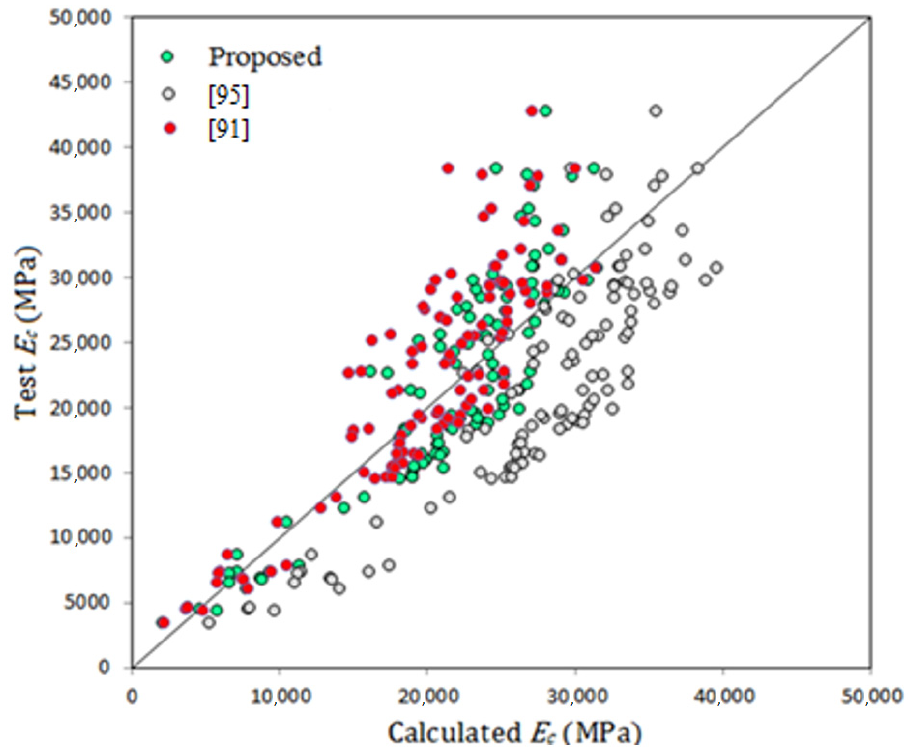
Figure 13. Test and calculated elastic modulus of GPC.